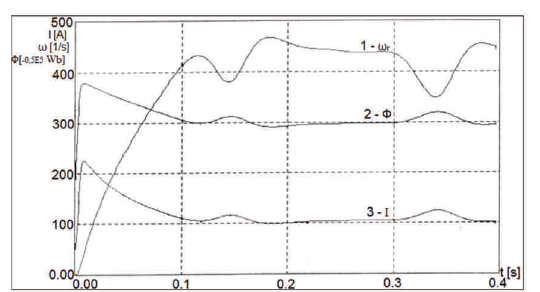
Fig. 5. Solution of the system of differential equations (1 – angular veloci- ty, 2 – magnetic flux, 3 – current waveform)